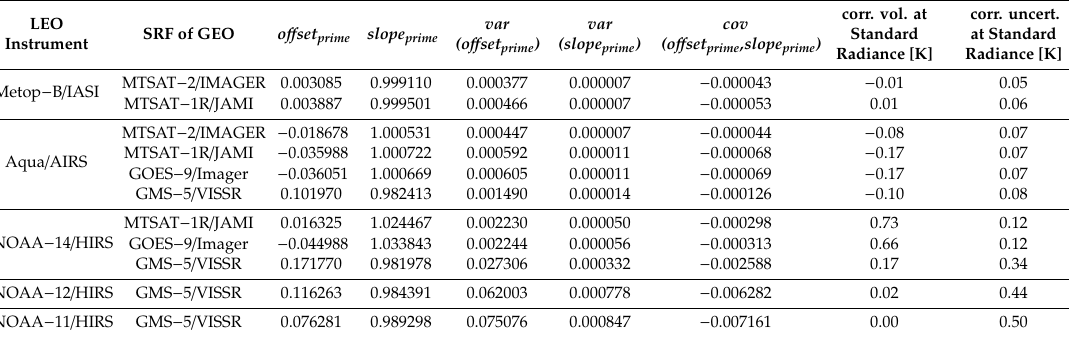
Table A7. Parameters of the prime reference correction for the WV channel (unit: mW / (m 2 sr cm − 1